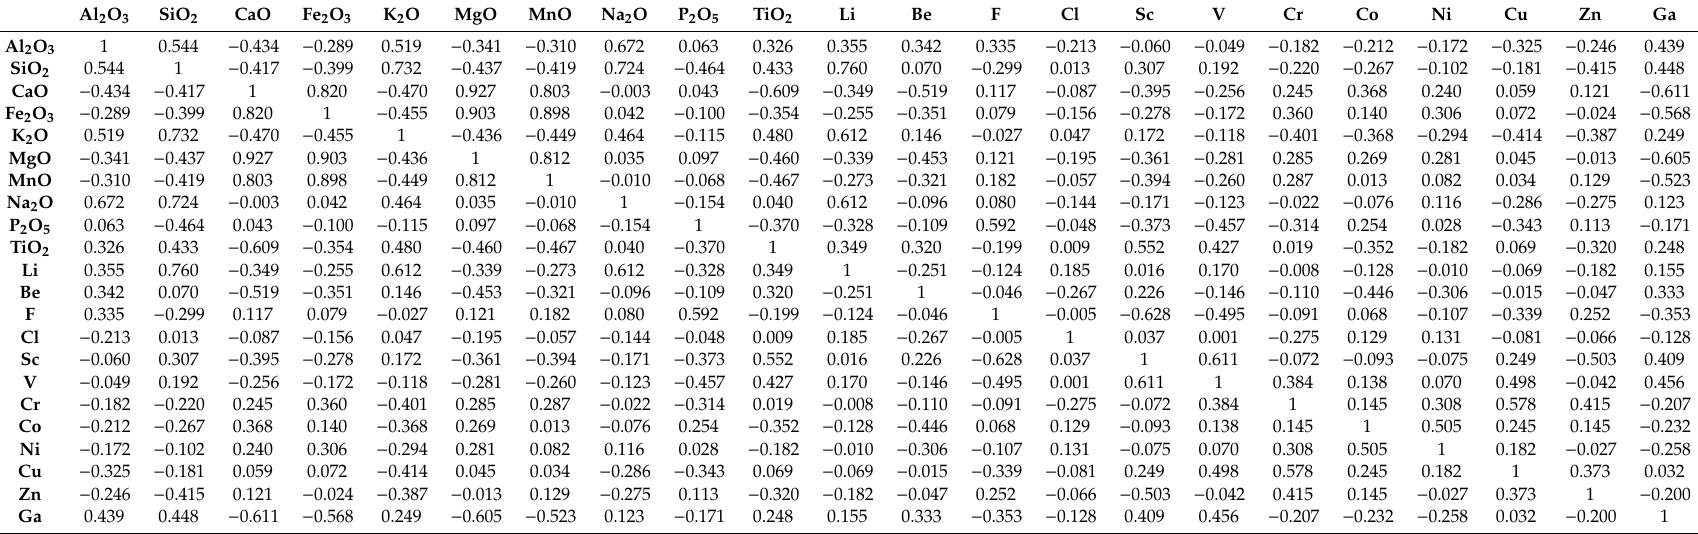
Table 7. Correlation using the clr on coal and ash basis (Adaohai